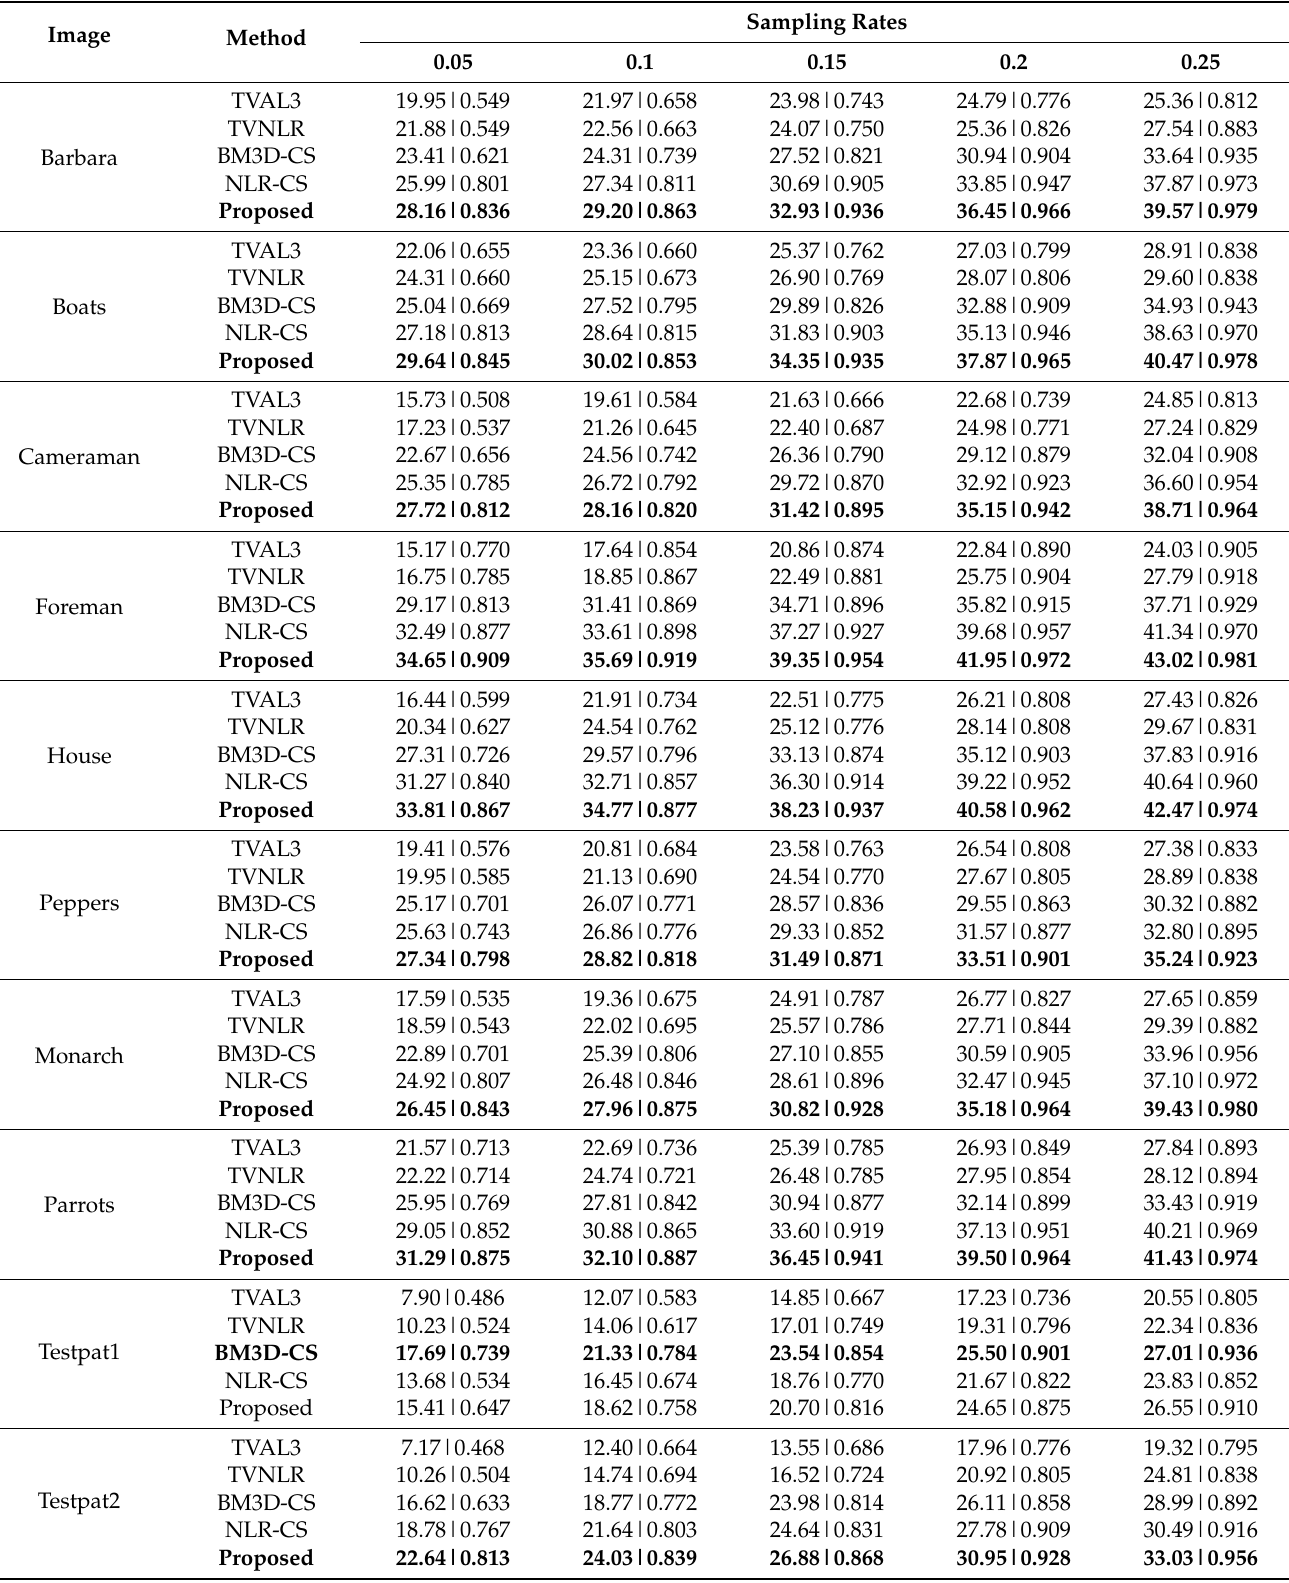
Table 1. The PSNR (dB, left) and SSIM (right) of test images at different sampling rates reconstructed by the proposed algorithm and comparison algorithms. The best performance algorithm is shown in